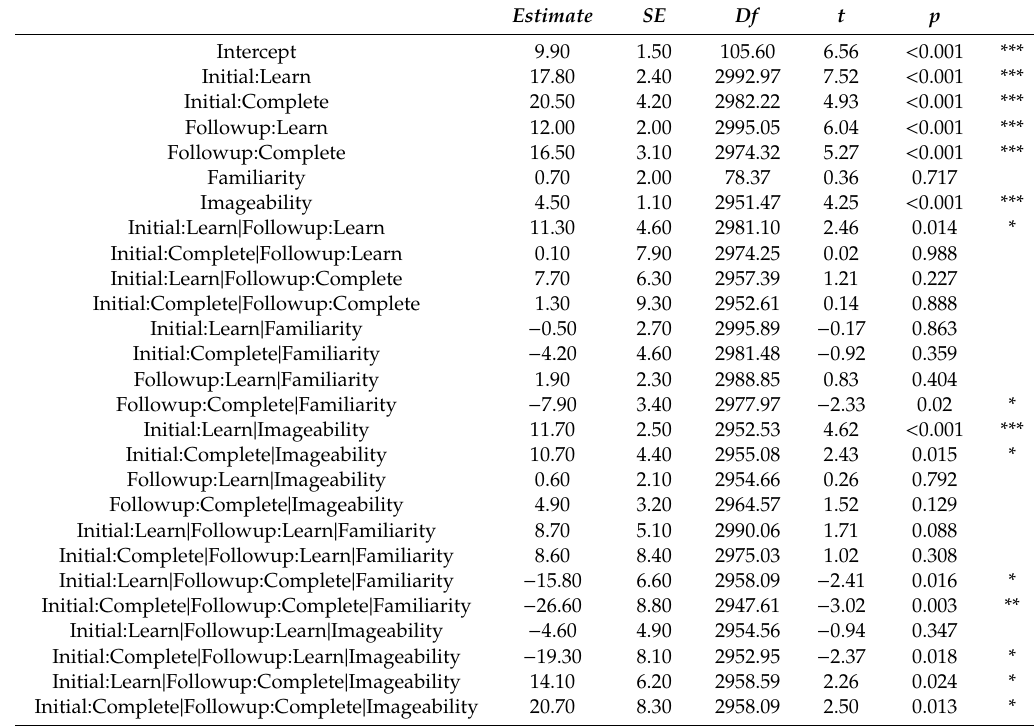
Table 1. Parameter estimates for linear mixed e ff ect regression model of Initial Training score, Follow-up Training score, and Language on surprise recall